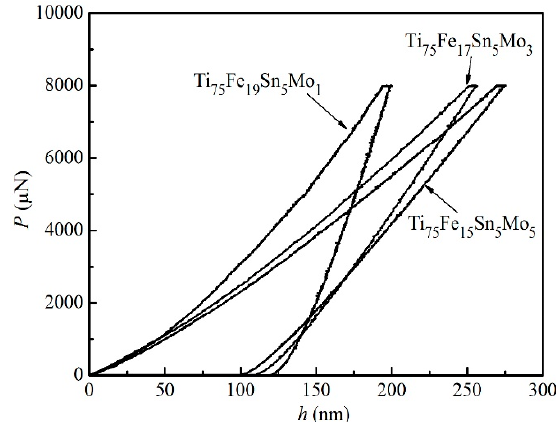
Figure 10. Representative load/unload ( P )-displacement ( h ) nanoindentation curves for the Ti–Fe– Sn–Mo